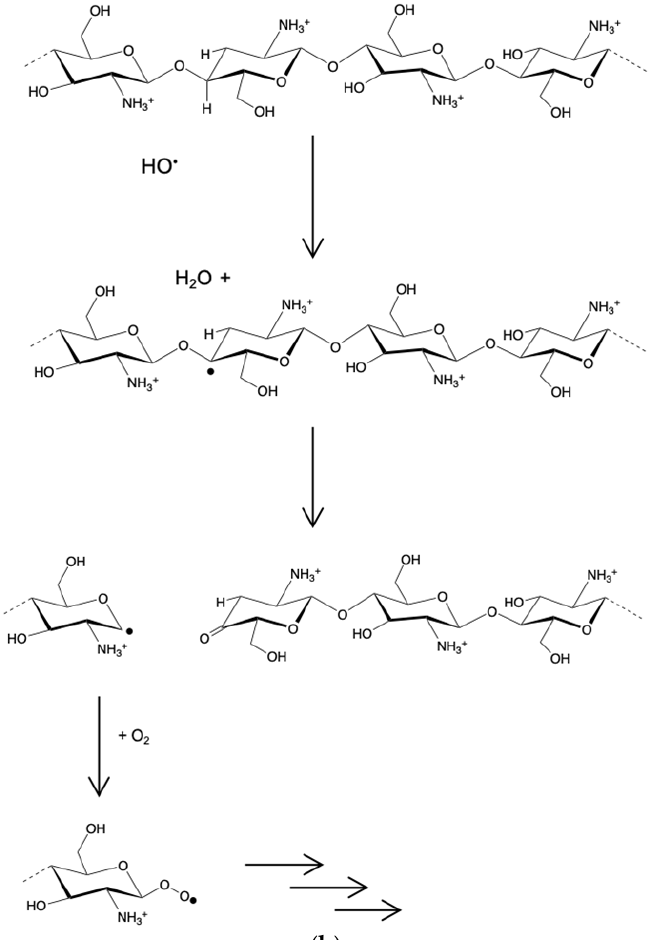
Scheme 2. Sketch representing the decrease in length for immobilised chitosan chains subject to attacks by HO• radicals ( a ) and example of a possible chain scission mechanism in the aerated aque- ous solution used for grafting ( b